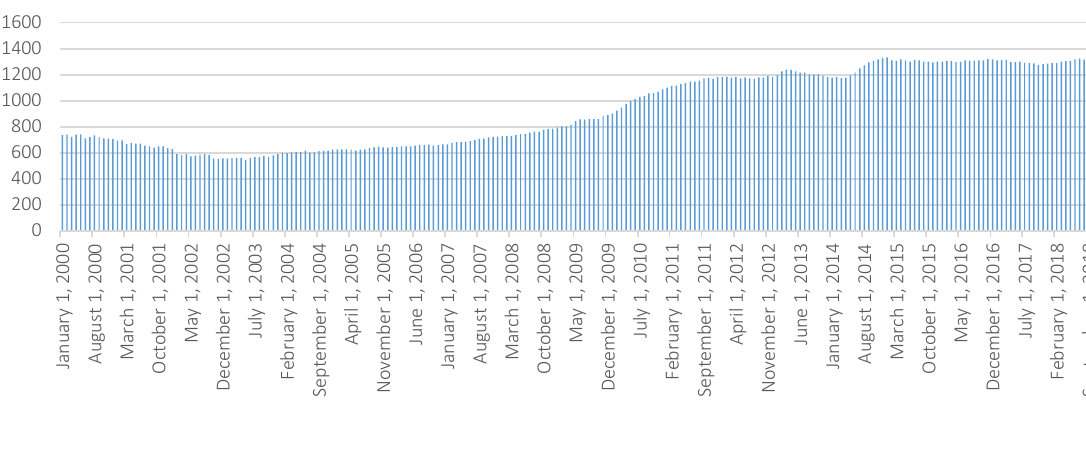
Figure 3A. Descriptive statistics – number of